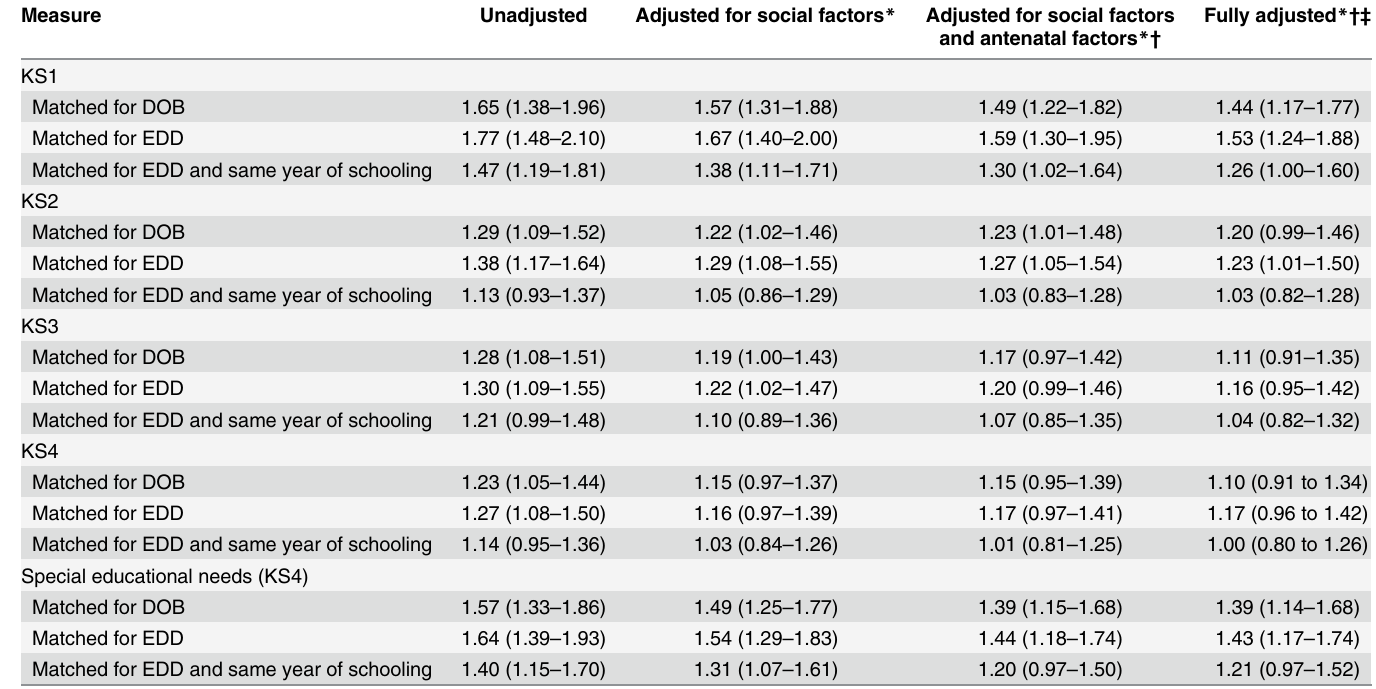
Table 3. Association between being born preterm ( < 37 weeks) and school